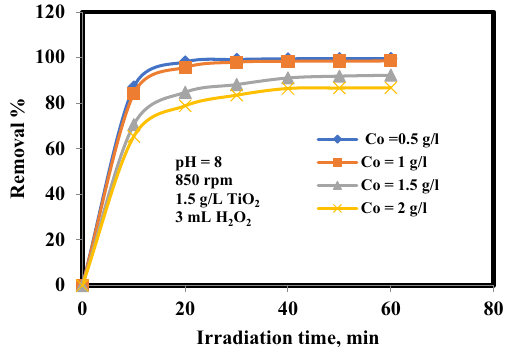
Figure 4. Influence of initial oil concentration on the removal efficiency of